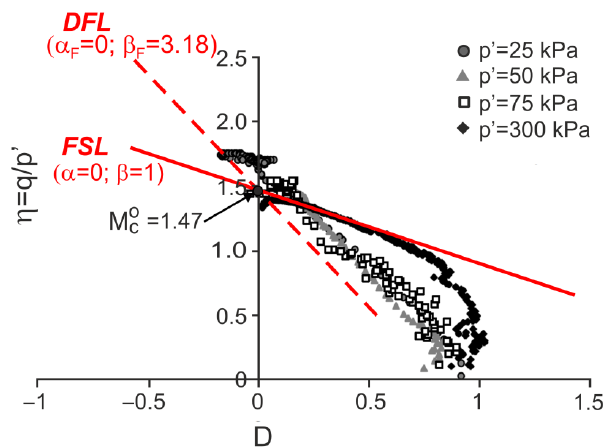
Figure 9. Stress ratio–dilatancy relationships for the drained triaxial compression of decomposed granitic residual soil (adapted from [7]). Reprinted from Publication Proceedings of the 15th Eu-